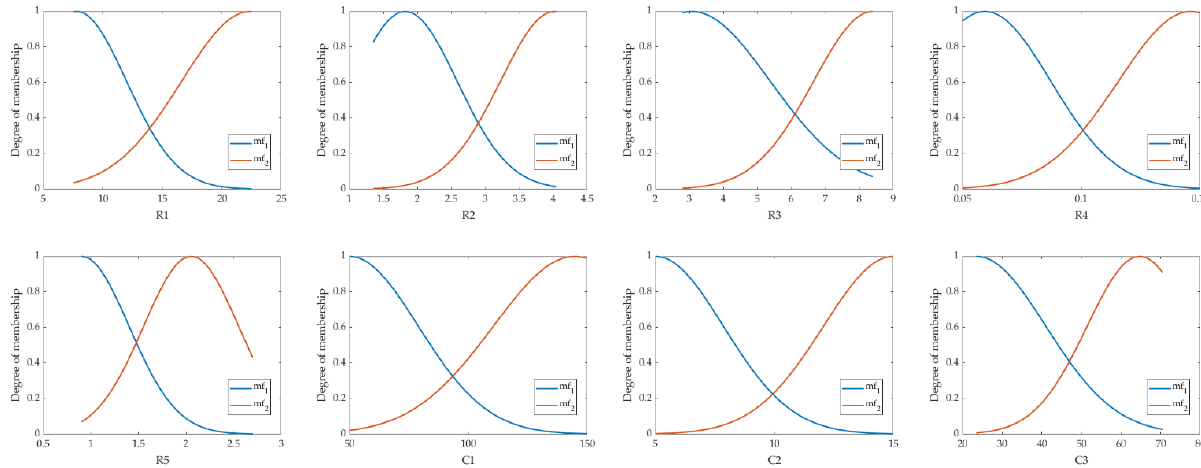
Figure 8. Membership functions obtained after tuning the FIS for Av (2nd step).